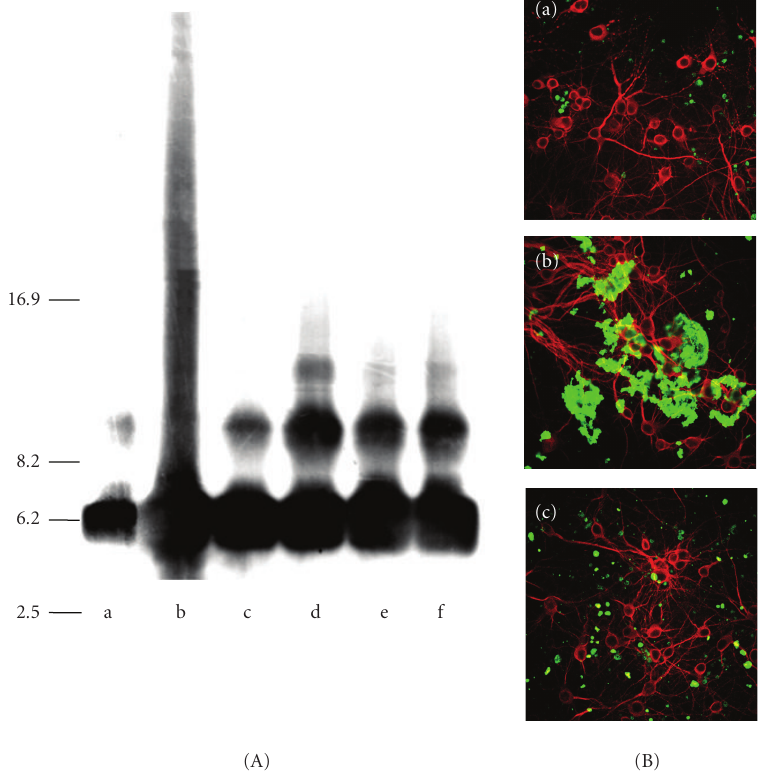
Figure 4: Aggregation of A β P by Al and other metals. (A) Immunoblotting of A β P preincubated with Al and other metals. The solutions of A β P(1–40) were incubated at 37 ◦ C for 24h with or without 1mM of various metals, and were analyzed by SDS-PAGE and immunoblotting using an antibody to A β P. Each lane contained 4 μ g A β P(1–40). Lane a: control, b: AlCl 3 , c: ZnCl 2 , d: CuCl 2 , e: FeCl 3 , f: CdCl 2 , Modified from [134]. (B) Deposition of A β P on surfaces of cultured neurons. Solutions of A β P(1–40) preincubated at 37 ◦ C for 24 h (a), with 1 mM AlCl 3 (b), or 1mM ZnCl 2 (c) were applied to cultured rat cortical neurons. After 2 days of exposure, cells were washed and double immunostained with a polyclonal antibody to A β P (green) and a monoclonal antibody to MAP2 (red), and observed by laser confocal microscope. Scale bar: 50 μ m, modified from